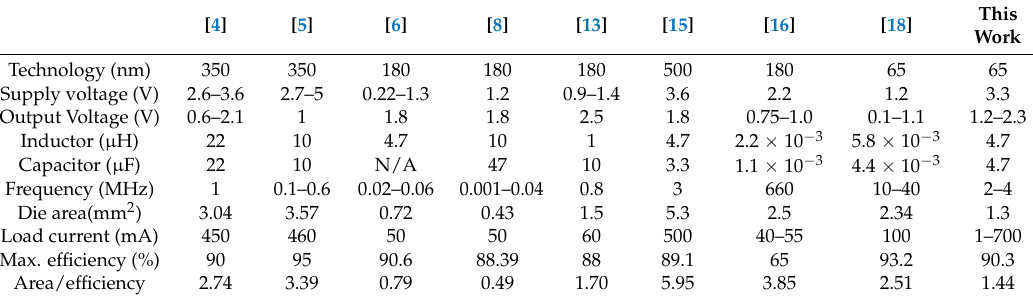
Figure 11. Measured power efficiency of buck converters. Table 1. Performance comparison of DC–DC